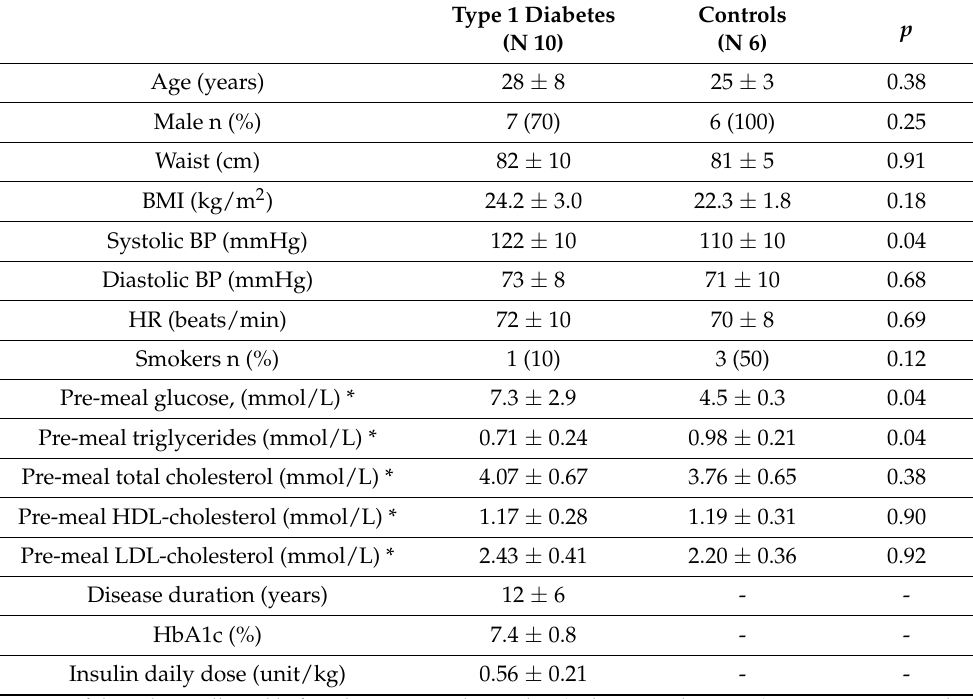
Table 2. Anthropometric, clinical, and biochemical characteristics of subjects with type 1 diabetes and control